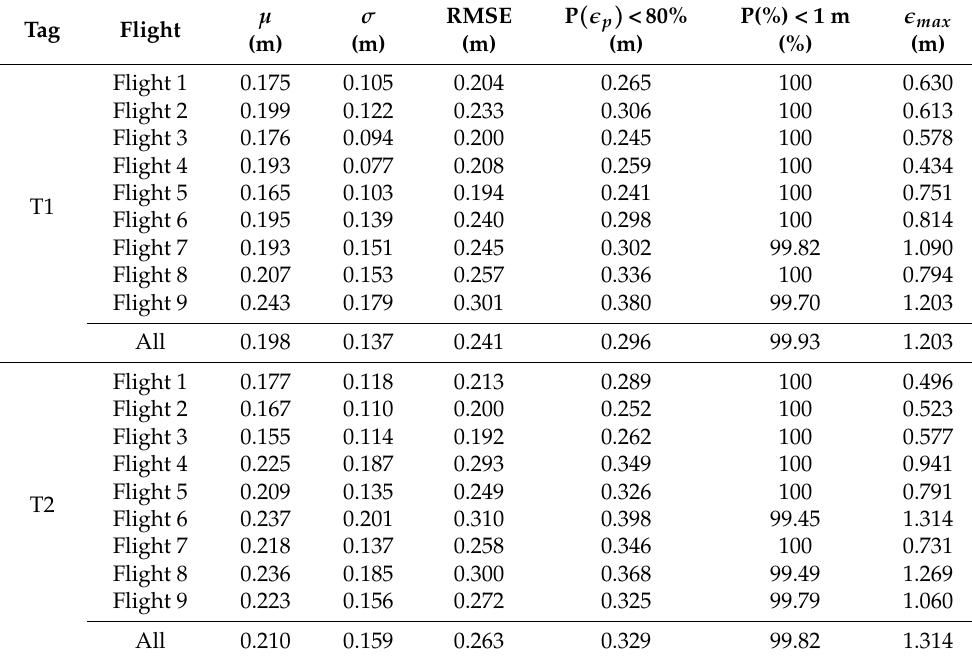
Table 7. Accuracy data fusing UWB and inertial